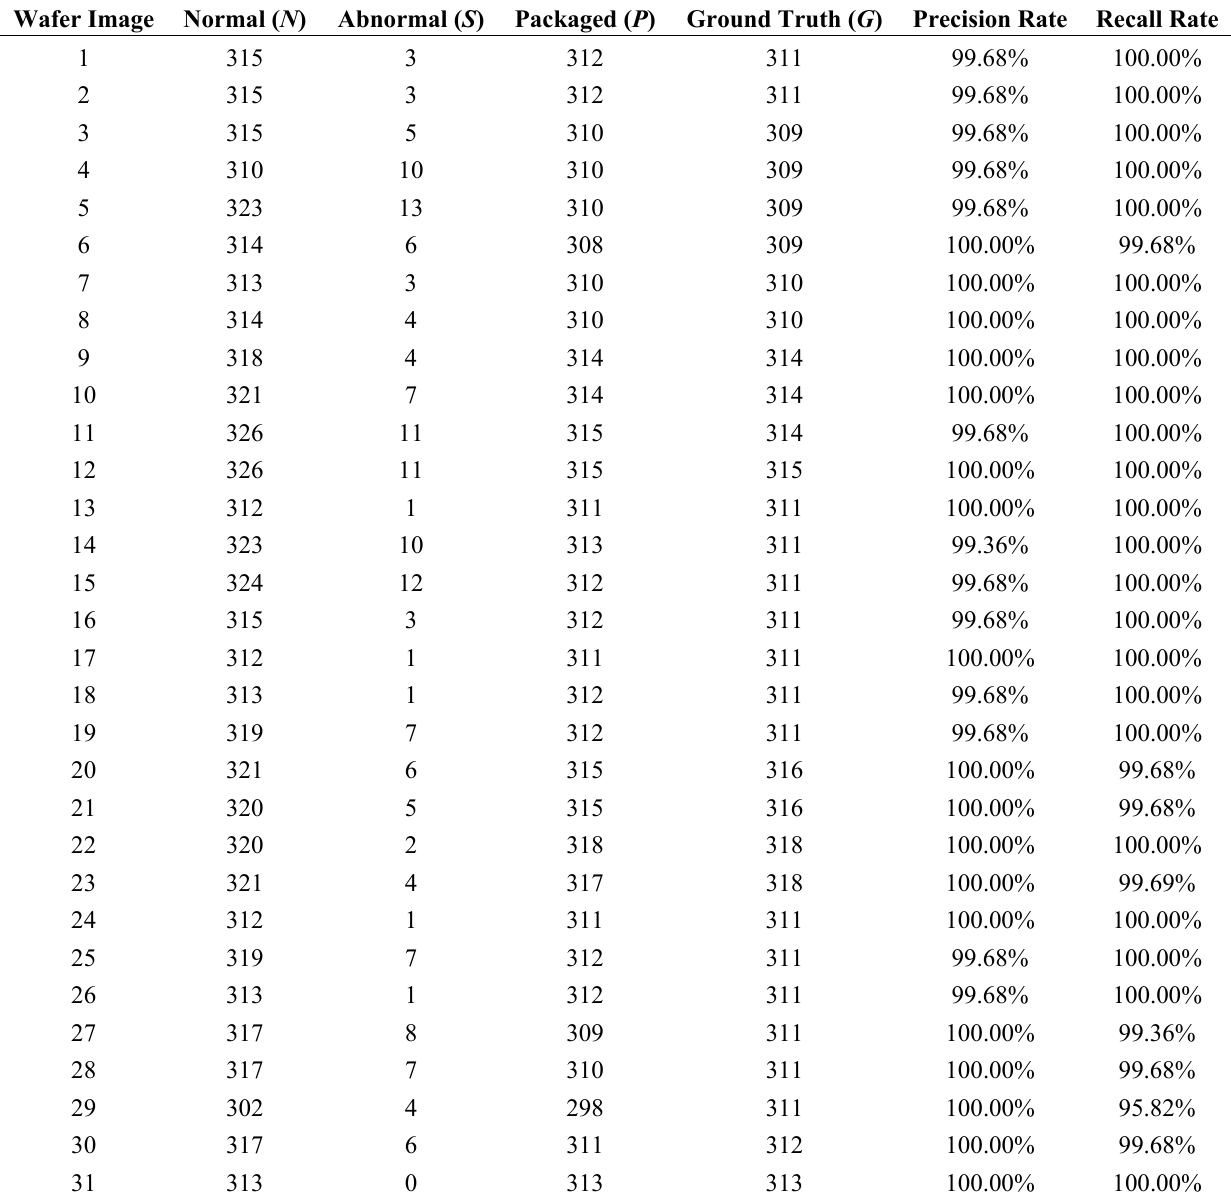
Table 1. The recall and precision results in the